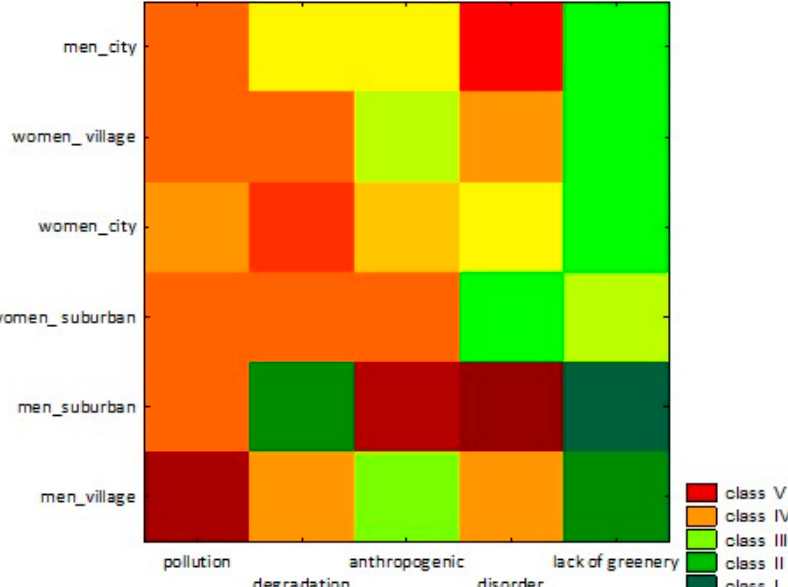
Figure 10. Standardized assessment of the degraded landscape with respect to the five most common characteristics depending on the gender and place of residence. (EnvEng and CivEng students combined, n = 244).